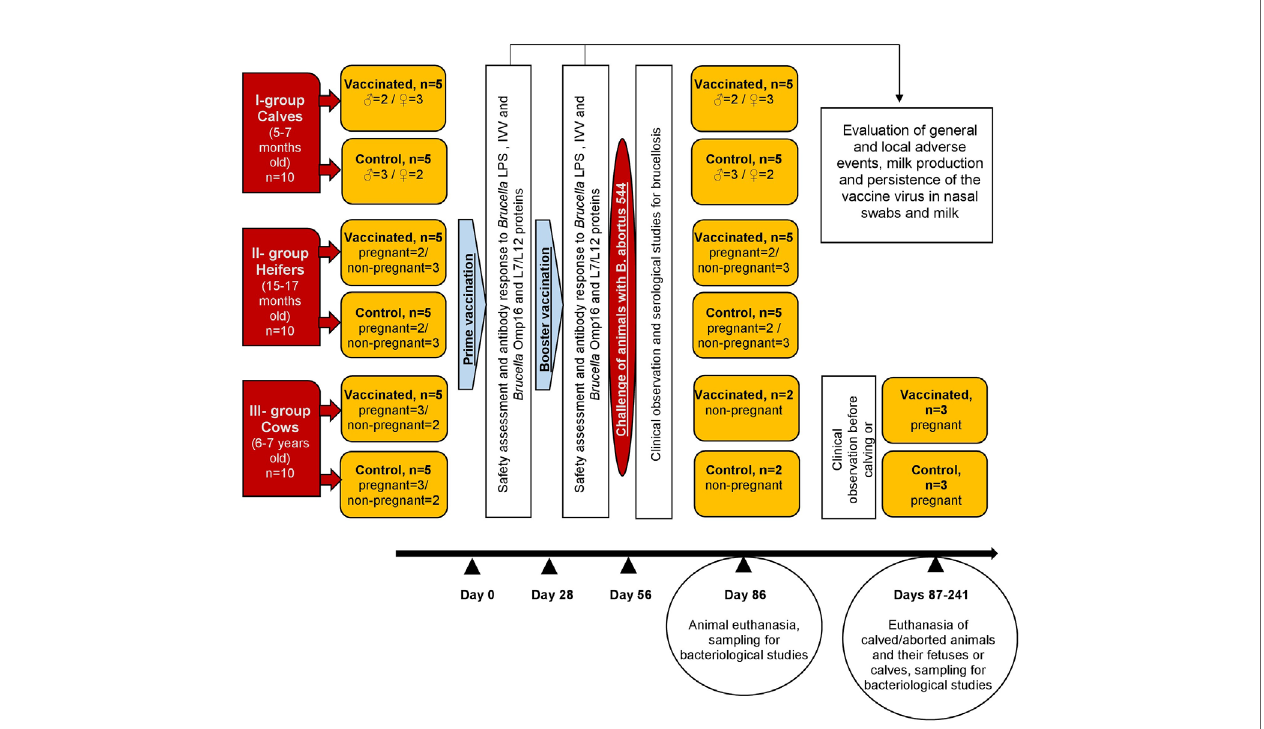
FIGURE 1 | Experimental design and